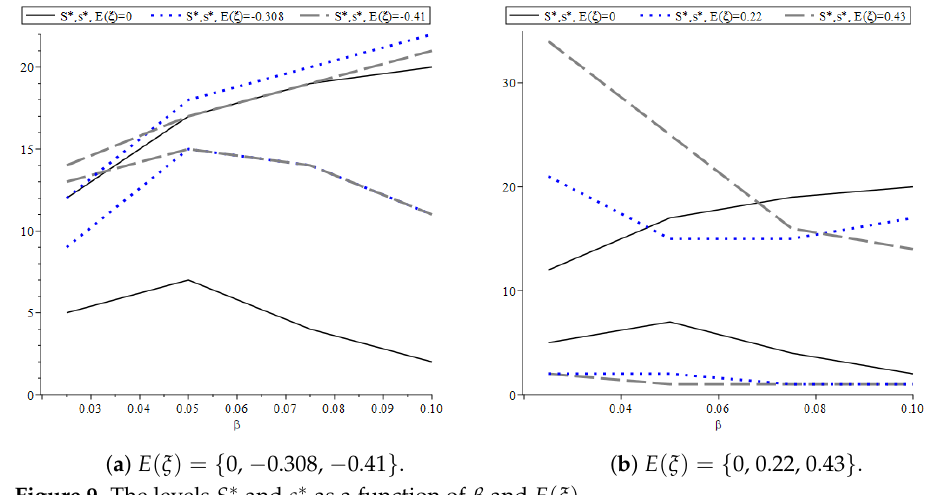
Figure 9. The levels S ∗ and s ∗ as a function of β and E ( ξ )